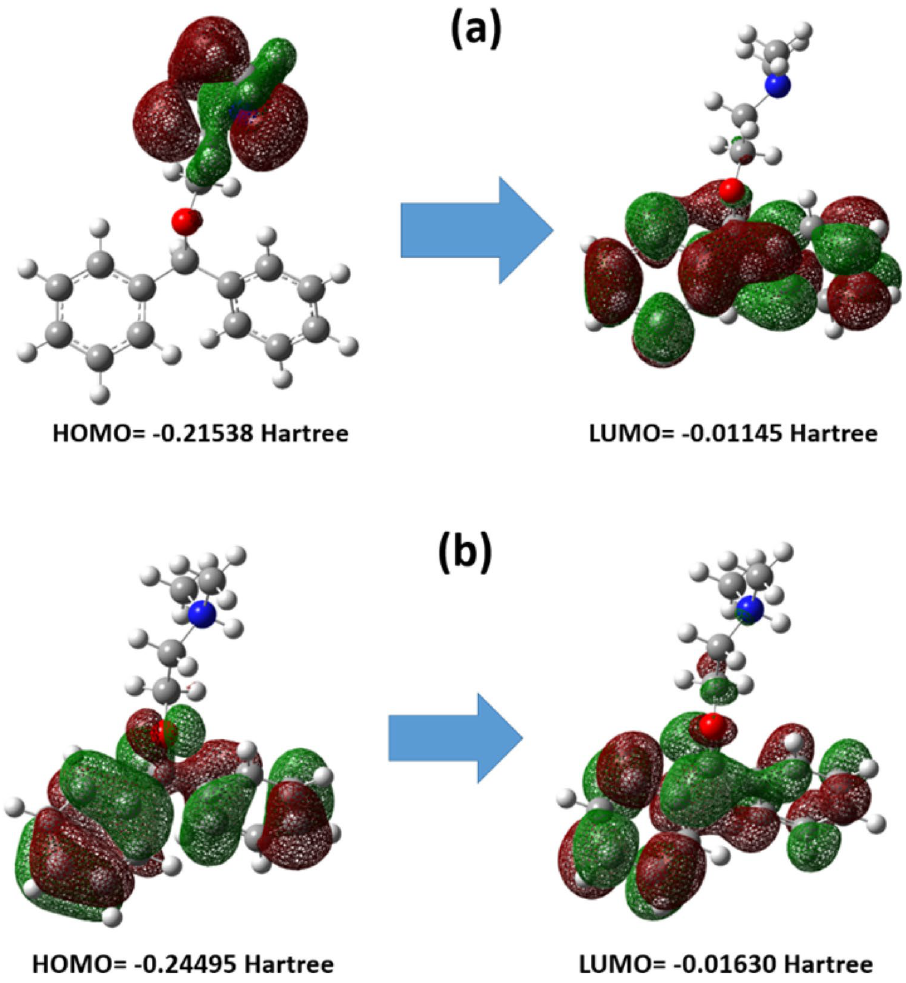
Figure 13. The HOMO and LUMO of neutral ( a ) and protonated ( b ) DPH. The color scheme is the same as Fig. 1. The positive and negative surfaces are presented with red and green colors,